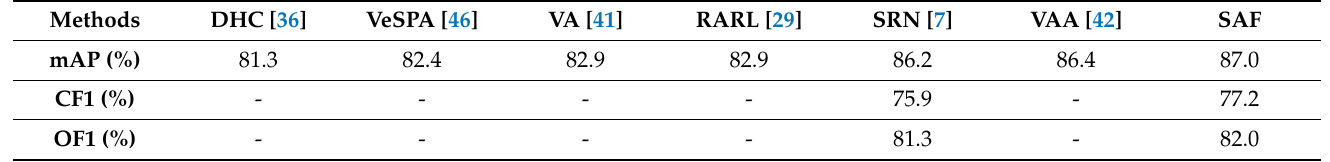
Table 4. Classification results of different methods on WIDER